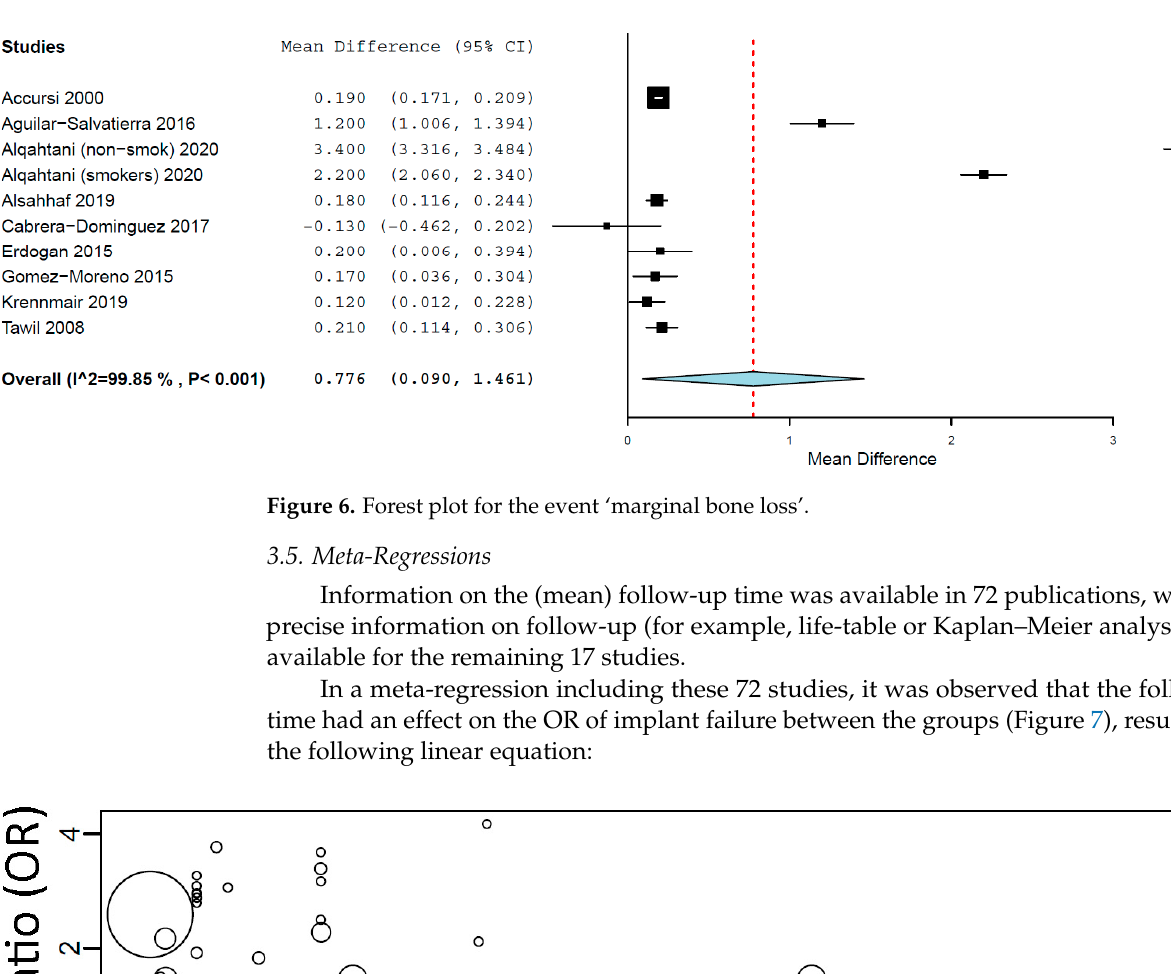
Figure 6. Forest plot for the event ‘marginal bone loss’.